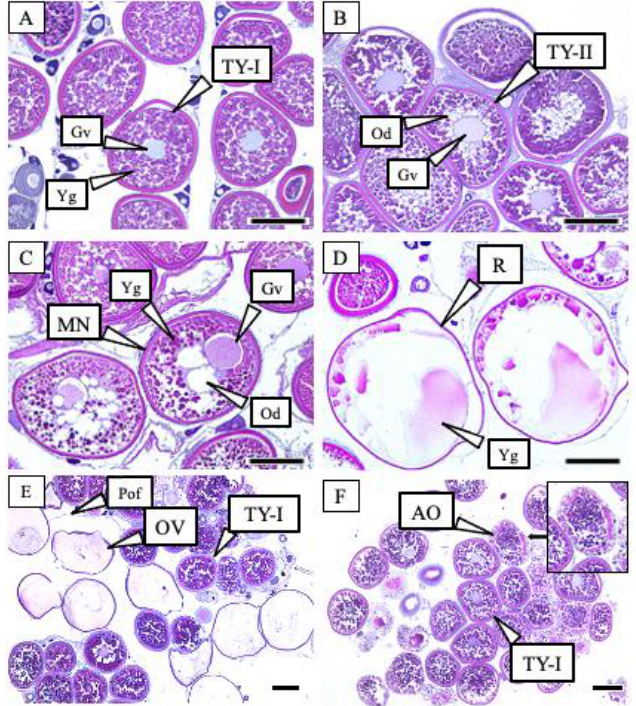
Figure 3. Oocyte development stage during final oocyte maturation. ( A ) Tertiary yolk stage-I (TY-I): the oocyte is filled with yolk globules (Yg) and the germinal vesicle (Gv) is located in the center of the cytoplasm. ( B ) Tertiary yolk stage-II (TY-II): the oocyte is filled with yolk globules and oil droplets (Od) are gathered around the germinal vesicle. ( C ) Migratory nucleus stage (MN): yolk globules and oil droplets are coalesced, and the germinal vesicles have migrated to the animal pole. ( D ) Ripe stage (R): coalesced yolk globules are hydrated, and germinal vesicles have broken down. ( E ) An ovulatory ovary of a female: ovulated eggs (OV) are released from the follicle and post-ovulatory follicles (Pof) and pre-ovulatory oocytes remain in the ovigerous lamella. ( F ) An ovary with atretic oocytes (AO): atretic oocytes appeared in females reared in artificial conditions at 120 and 144 h. Scale bar = 200 μm.